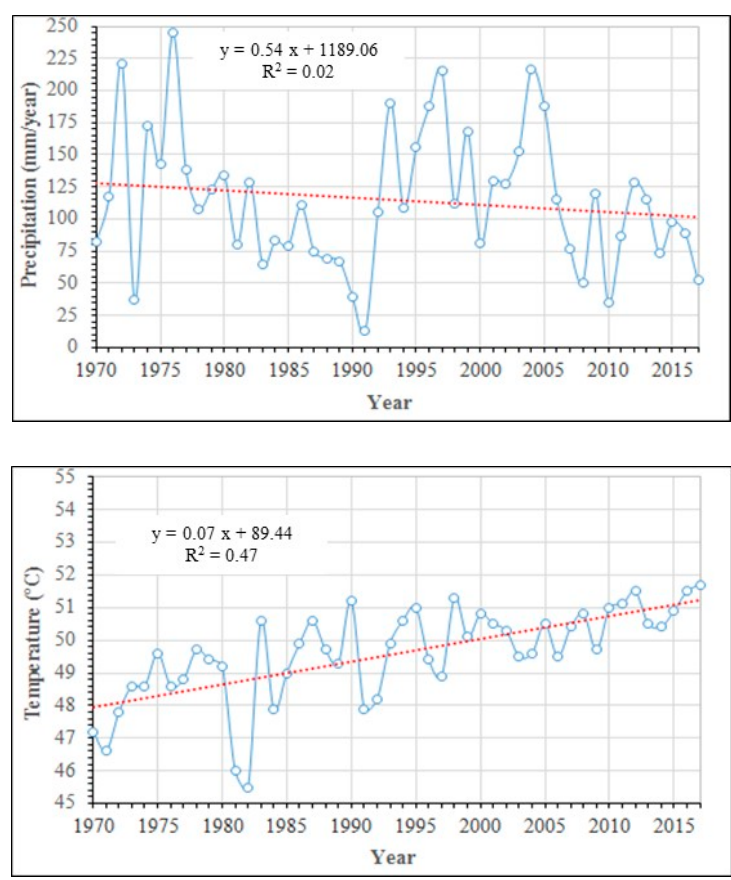
Figure 10. Annual precipitation rates and maximum temperatures over Kuwait State during the last half century (1970 to 2017).